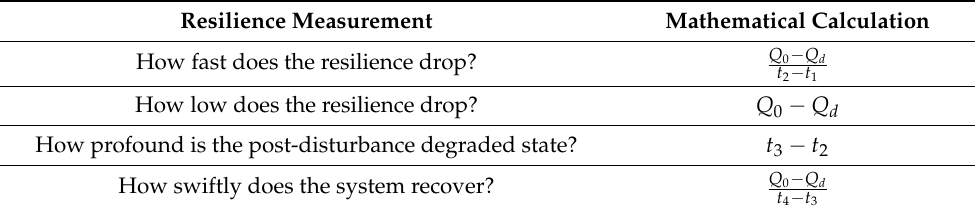
Table 2. Quantifying resilience based on the trapezoidal resilience curve [22].